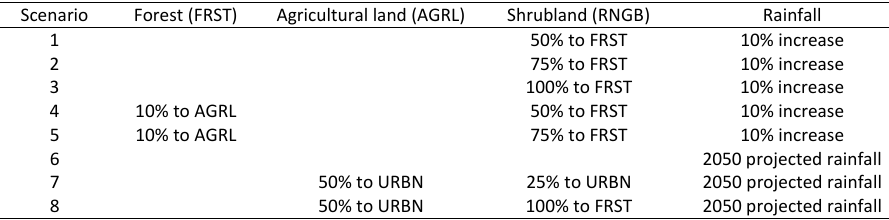
Fig. 4: Precipitation, evapotranspiration, surface runoff and baseflow map of year 2015 per subbasin of Muleta watershed Table 4: Land cover and climate change scenarios for Muleta watershed Table 4: Land cover and climate change scenarios for Muleta